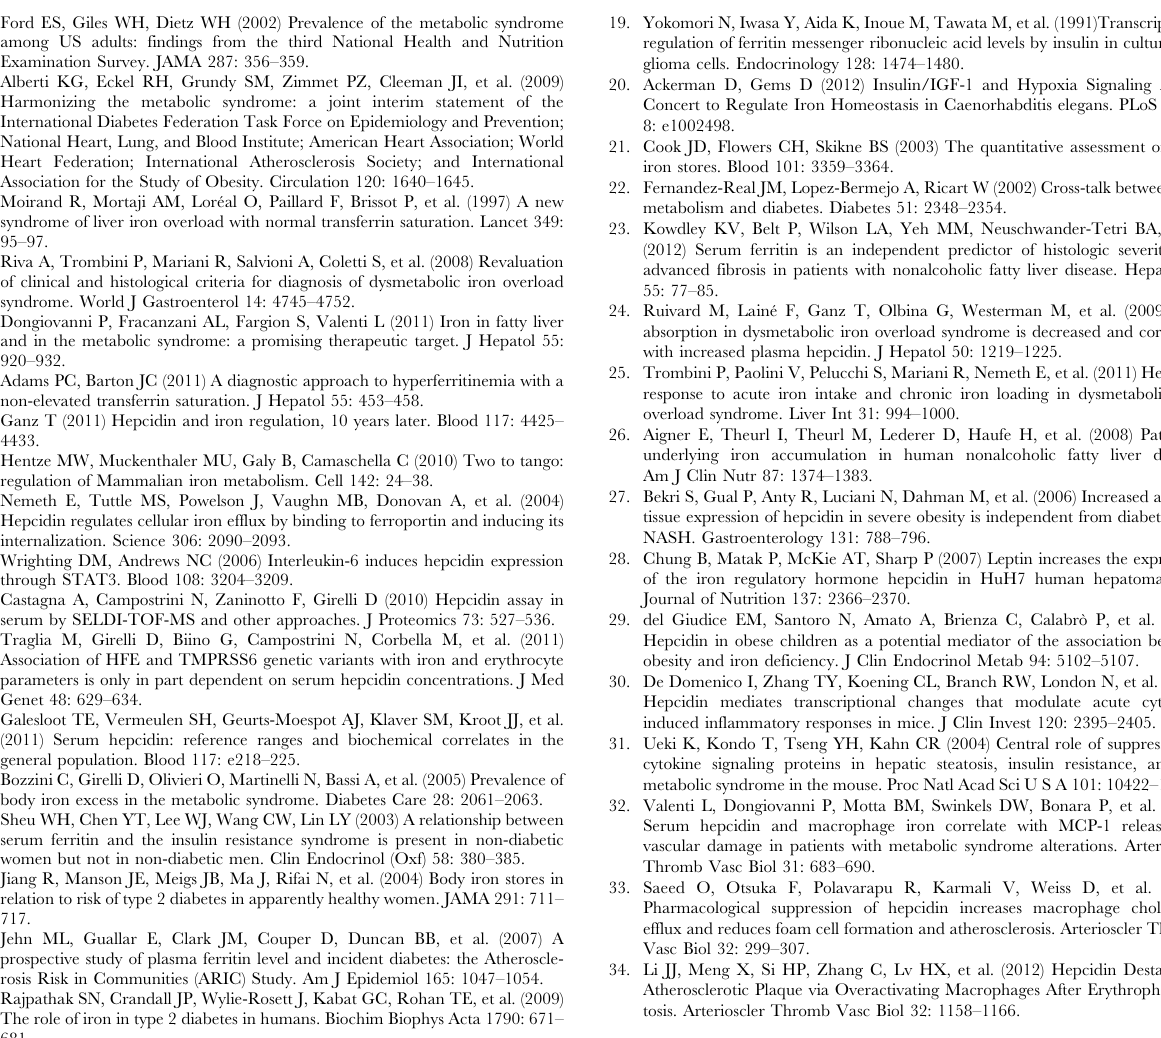
Table S2 Associations with hepcidin at univariate analyses. Table S3 Predictors of hepcidin in males and females, considering the individual MetS features as